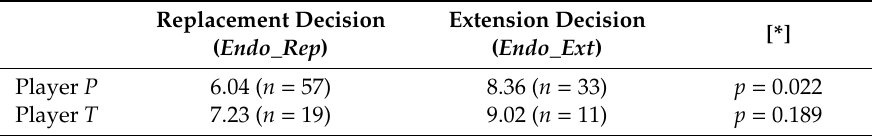
Table 5. Contributions by player type in part I by subsequent